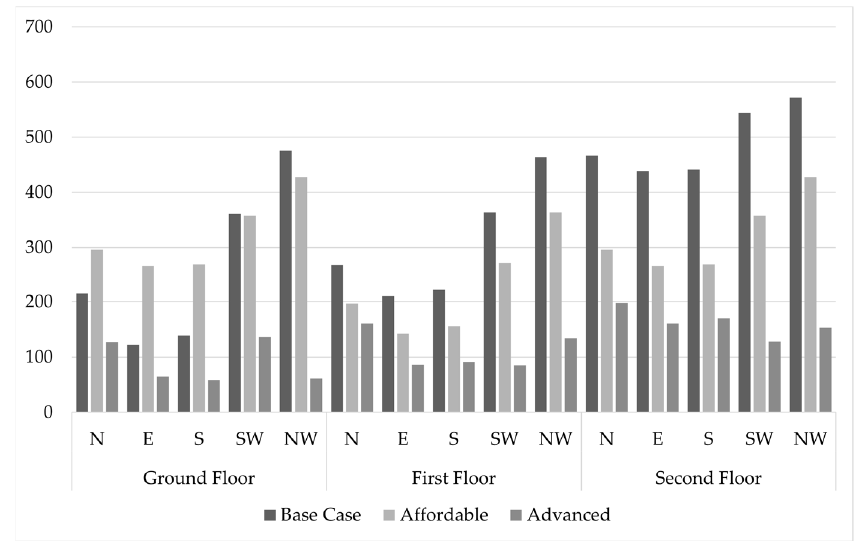
Figure 7. Decrease in discomfort hours with envelope retrofit strategies.